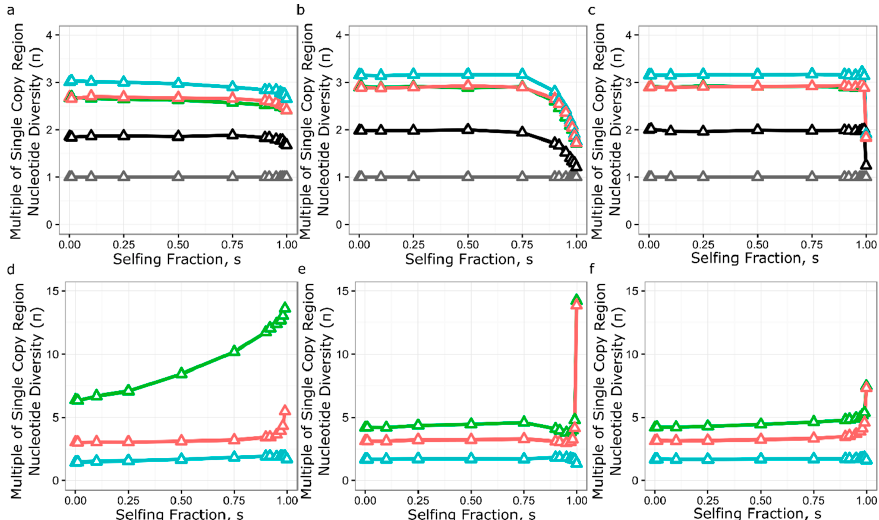
Figure 5. Effect of selfing fractions and IGC rates for two and three copy gene families undergoing intergenic gene conversion. Each point represents the average equilibrium nucleotide diversity from 200 independent extended SeDuS simulations. Nucleotide diversities relative to a single copy locus for one copy (grey), two copy (black), and three copy (green, blue, and orange are copies one, two, and three, respectively) systems are shown. ( a – c ) Neutrality. ( d – f ) Balancing selection maintaining copy two at 50% frequency within the population. ( a , d ) IGC rate = 0.2. ( b , e ) IGC rate = 8.4. ( c , f ) IGC rate = 200.